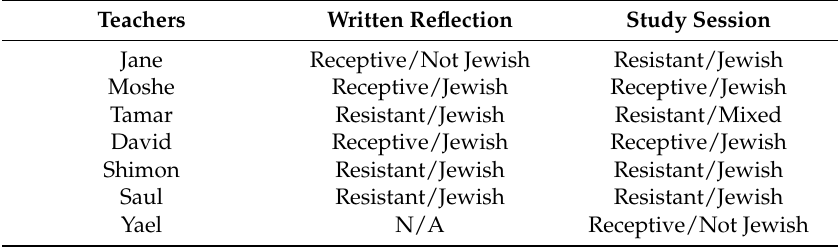
Table A3. Teachers’